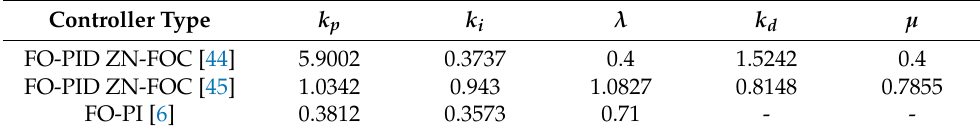
Table 1. FO-PID controllers for the integrative time delay process.